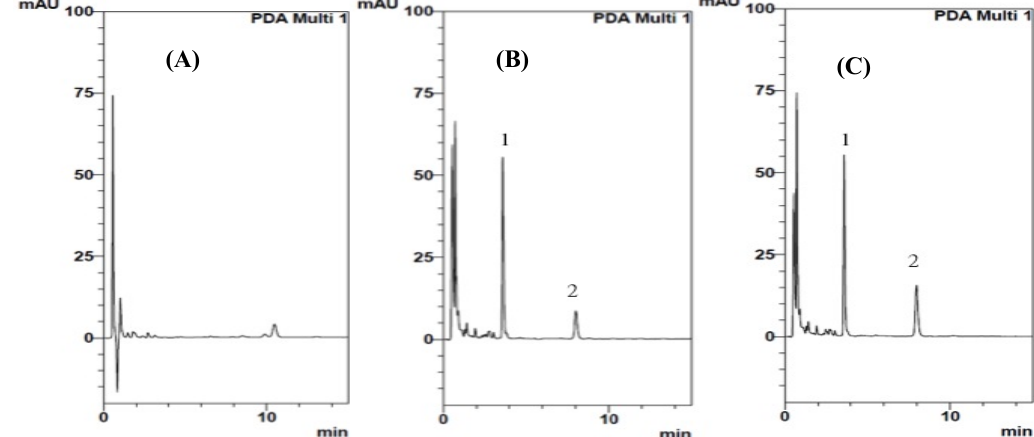
Figure 1. HPLC chromatograms of intravenous sildenafil after oral administration of the Epimedium sagittatum extract. ( A ) blank plasma, ( B ) blank plasma spiked with sildenafil (1 µg/mL), ( C ) plasma sample collected at 15 min after treatment of epimedii extract 2 h before sildenafil administration (10 mg/kg). 1: Internal Standard ( p -hydrobenzoate), 2: sildenafil.